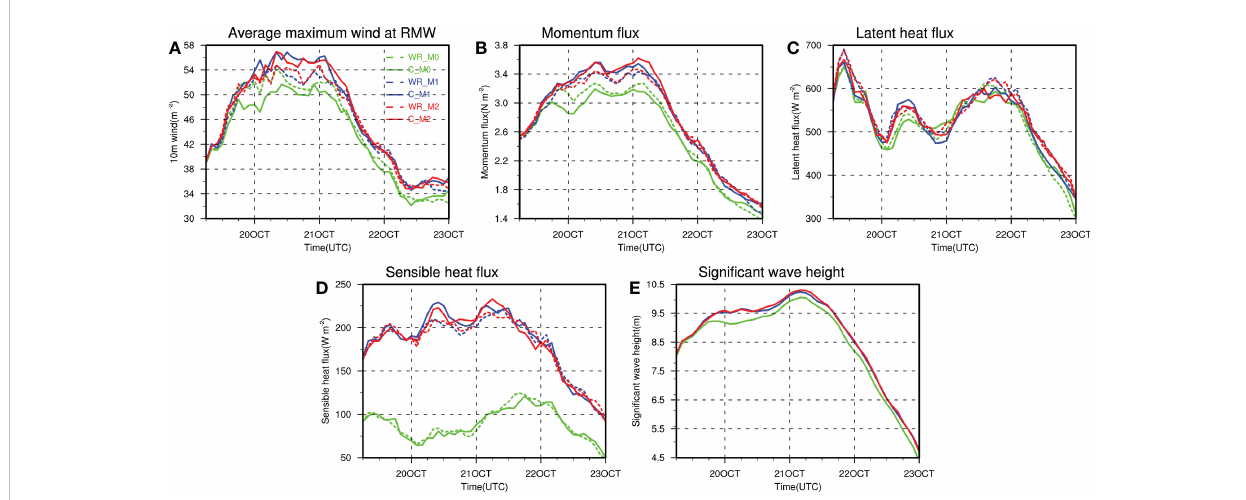
FIGURE 11 Time series of simulated (A) azimuthally averaged peak surface wind speed at the radius of maximum wind (RMW), (B) momentum fl uxes, (C) latent heat fl uxes, (D) sensible heat fl uxes, and (E) signi fi cant wave height averaged over an annular area between radii of 0.5 and 3.0 times of RMW from 06 UTC 19 Oct to 00 UTC 23 Oct (M0 — green, M1 — blue, and M2 — red). The solid lines denote the fully coupled experiments while the dashed lines show the results of the no-wave effects